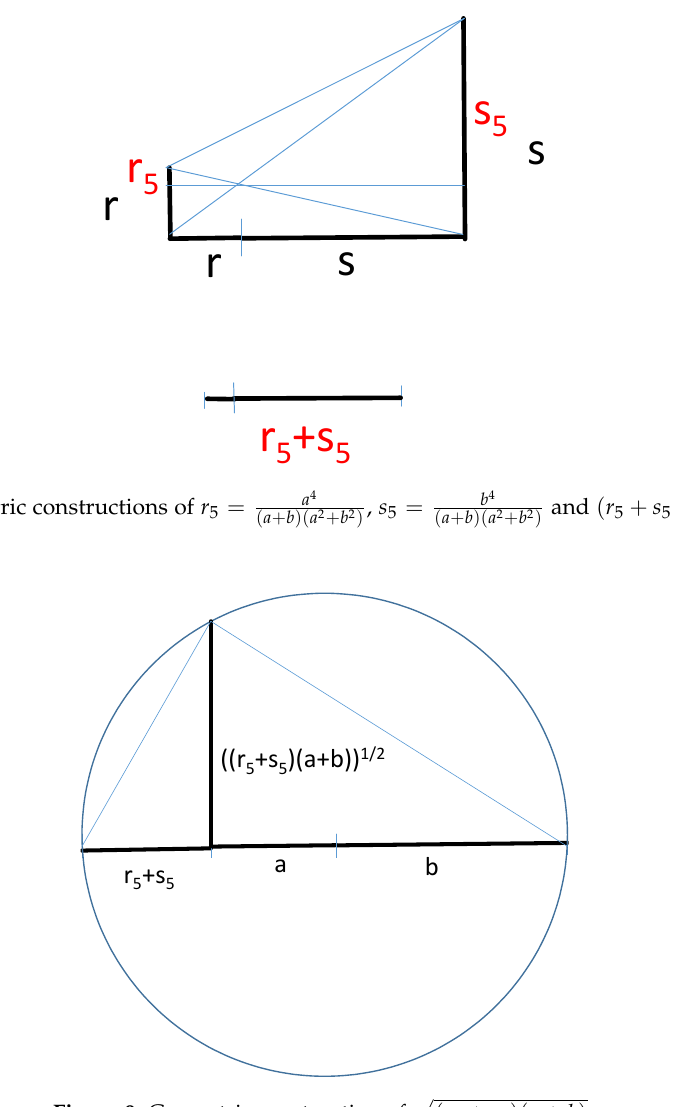
Figure 9: Geometric construction of Figure 9. Geometric construction of